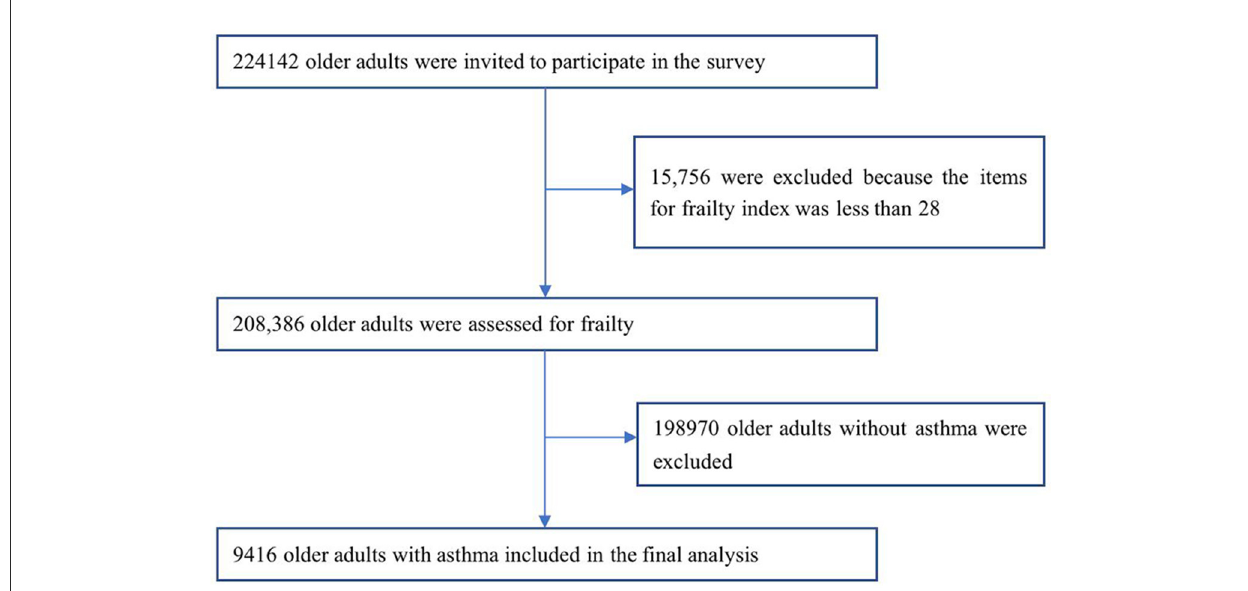
FIGURE1 Flowchart of study participants on frailty and pre-frailty prevalence in older adults with asthma in